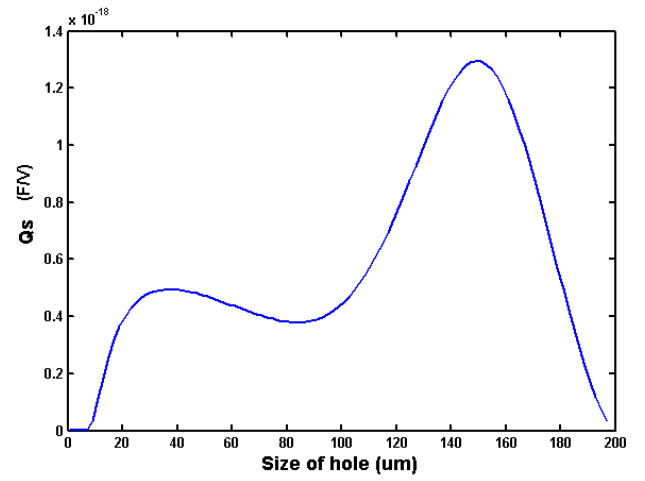
) for 200 μ m × 200 μ m s